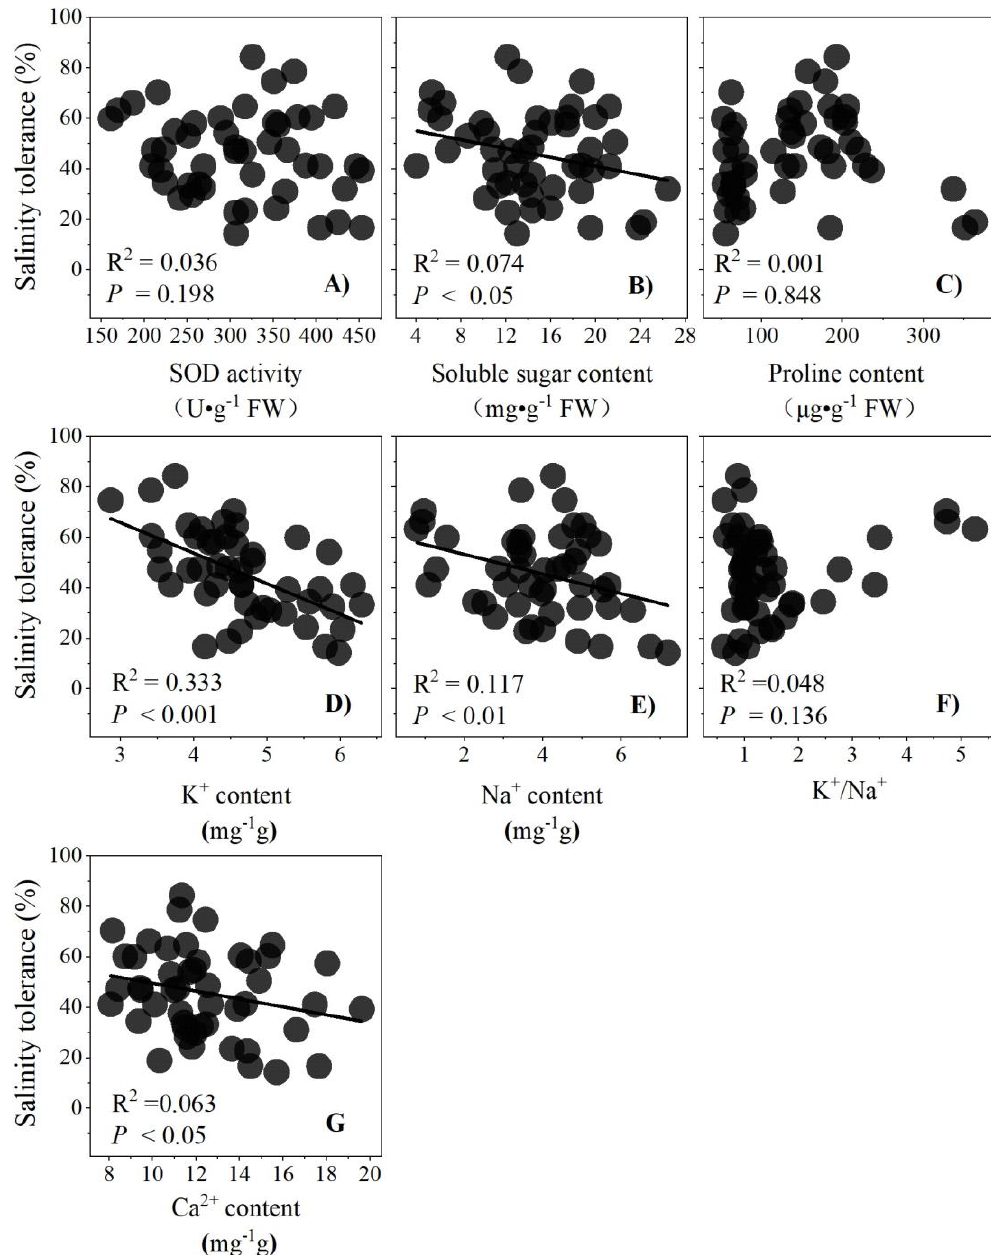
Figure 5. Relationships between salinity tolerance and assessed traits across different species and treatments. ( A ) SOD activity. ( B ) soluble sugar content. ( C ) proline content. ( D ) K + content. ( E ) Na + content. ( F ) K + /Na + . ( G ) Ca 2+ content.